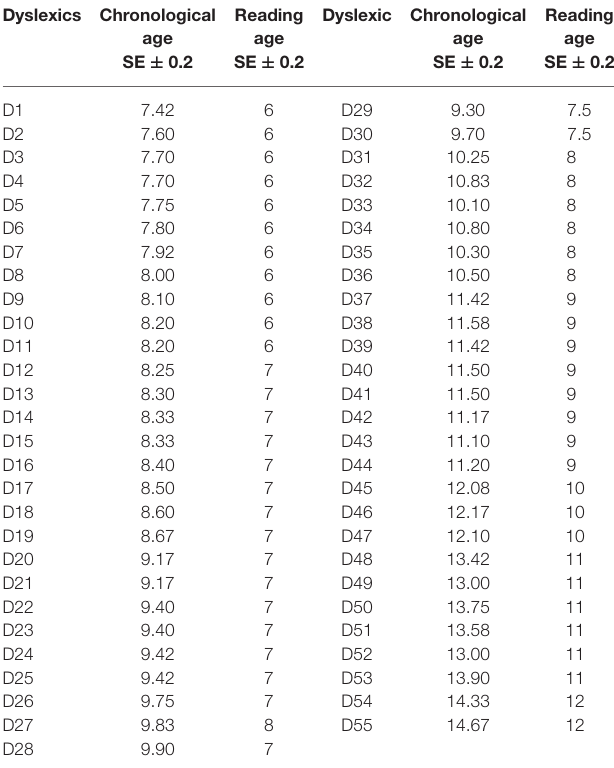
TABLE 1 | Chronological and reading age of each dyslexic child tested. Dyslexics Chronological Reading Dyslexic Chronological Reading age